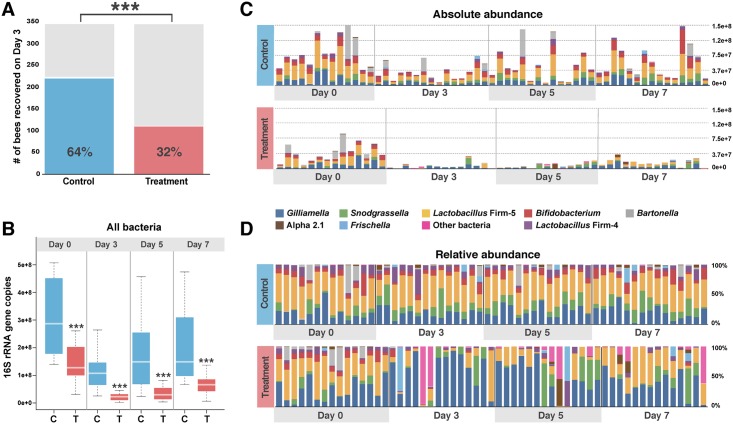
Survival rate and gut community changes for honeybees returned to the hive after tetracycline treatment.A) Number of workers recovered from the hive on Day 3 post-treatment (p < 0.0001, Chi-squared test). Similar results were obtained in a second experiment with a different hive (S2A Fig). See S2 Data for survival counts. B-D) Honeybee gut microbiome composition at post-treatment Days 0 (control n = 13, treatment n = 15), 3 (control n = 14, treatment n = 12), 5 (control n = 15, treatment n = 15), and 7 (control n = 15, treatment n = 14) B) Stacked column graph showing the absolute abundance of bacterial species present in control and treatment bees. C) Boxplot of total bacterial 16S rRNA gene copies for control and treatment bees post-treatment at Days 0, 3, 5, and 7. Box-and-whisker plots show high, low, and median values, with lower and upper edges of each box denoting first and third quartiles, respectively. *** = p < 0.0001, Wilcoxon rank sum tests. D) Stacked column graph showing the relative abundance of bacterial species in control and treatment bees at Days 0, 3, 5, and 7. See S1 Data for absolute and relative abundance data.